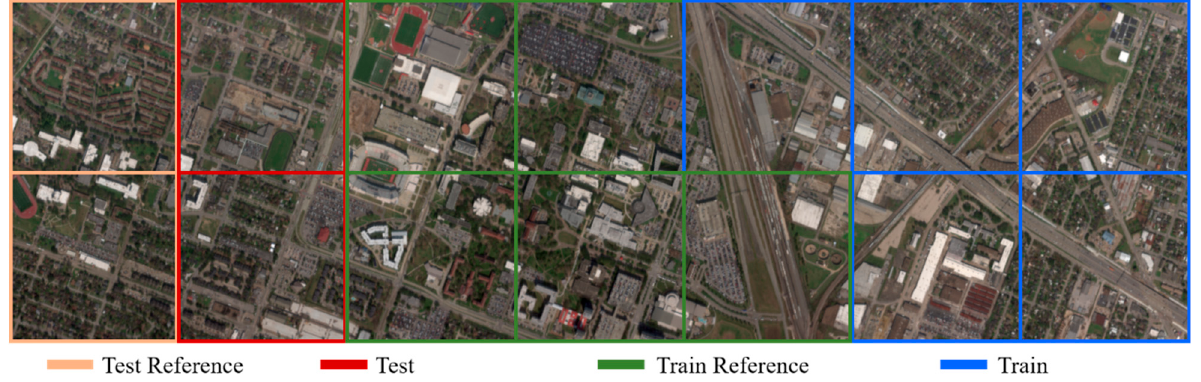
Figure 5. The original University of Houston data set was separated into many pieces, each with size of 601 × 596 pixels. The border color indicates the purpose of the image. of 601 × 596 pixels. The border color indicates the purpose of the image.